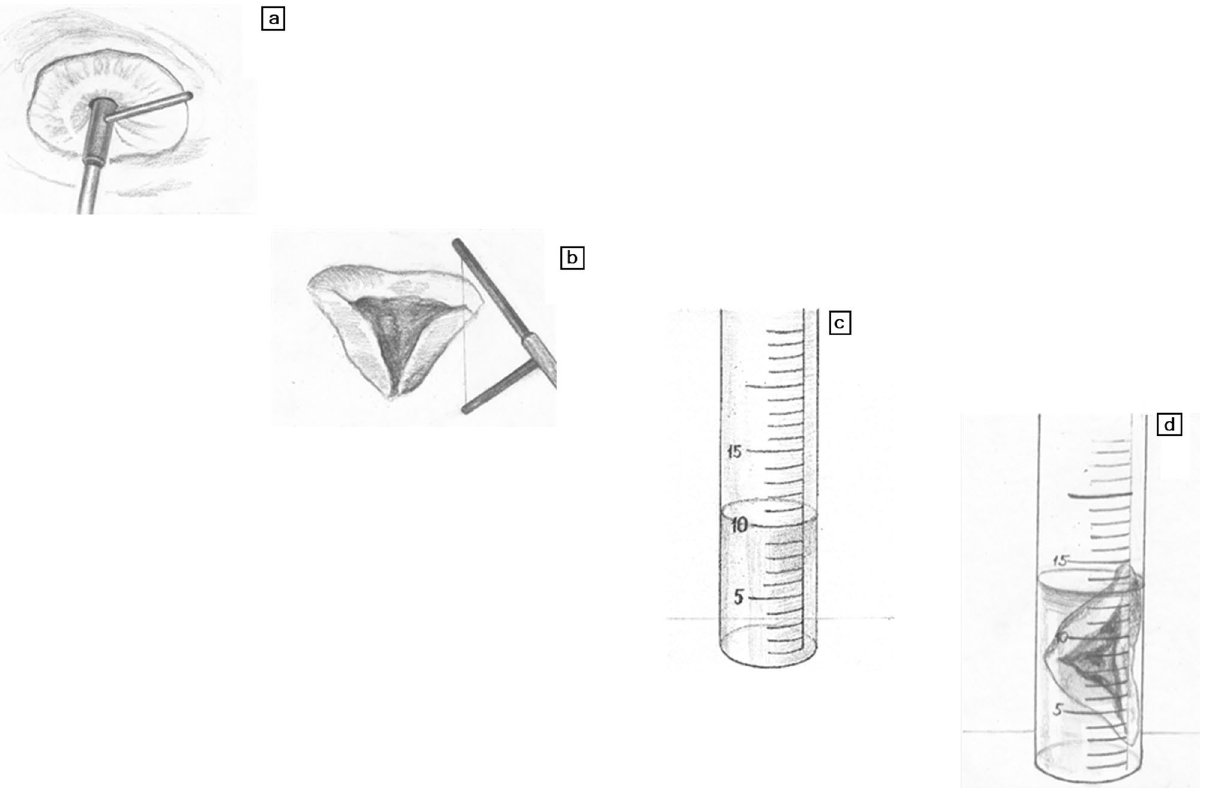
Figure 2. Assessment of the volume of the removed sample, defined as the cervical conization size (unit: cm 3 ): ( a ) conization of the pathologic part of the cervix; ( b ) removed sample; ( c ) a syringe with 10 ml water; ( d ) estimation of the volume of the removed sample in ml 3 . The authors gratefully acknowledge Iulia V. Chumarina